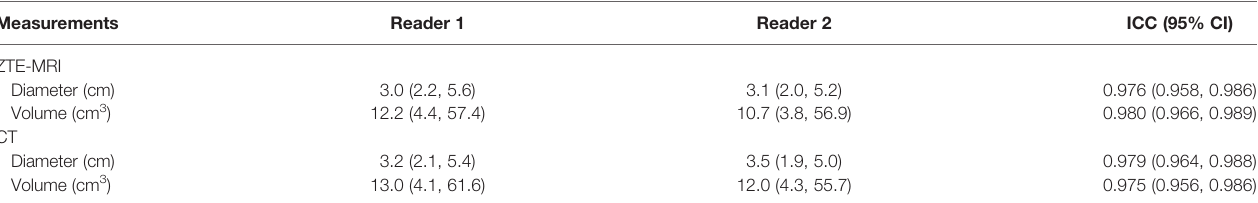
TABLE 4 | Inter-observer agreement for size measurements between ZTE-MRI and